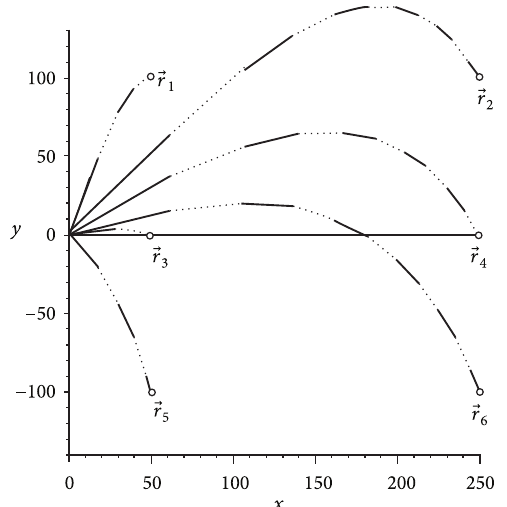
Figure 6: Planning to hit all six different target positions in exactly ten seconds. Figure 7: Planning trajectories to six targets, taking the exact same time as travelling with 25 m/s over the straight line from initial to target